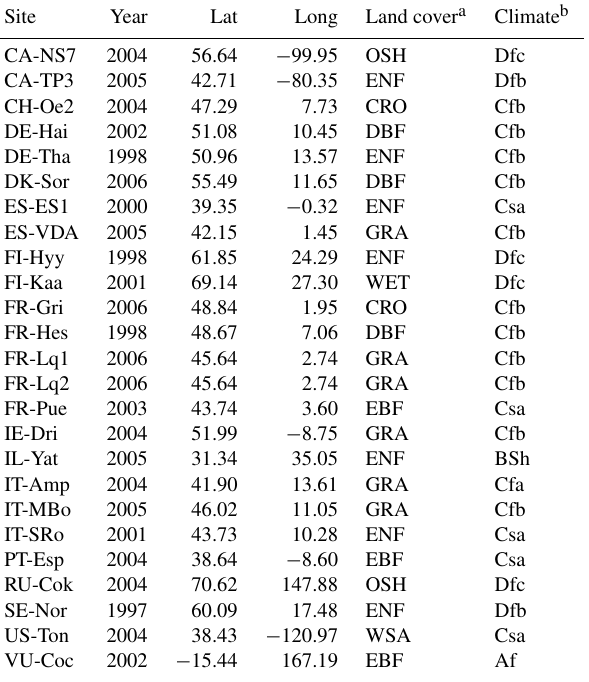
Table 1. Description of sites and times used for benchmarking REddyProc